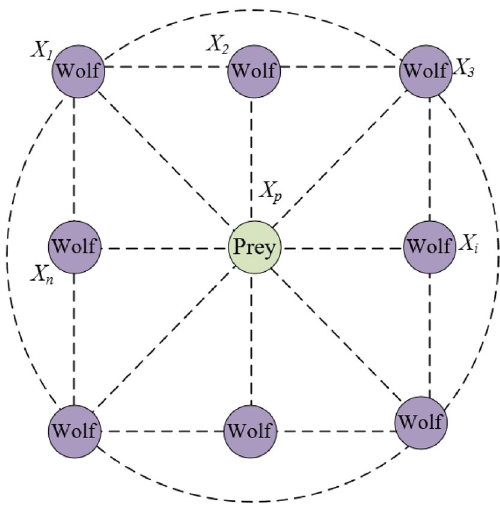
Figure 3. Illustration of positions of grey wolves and prey.